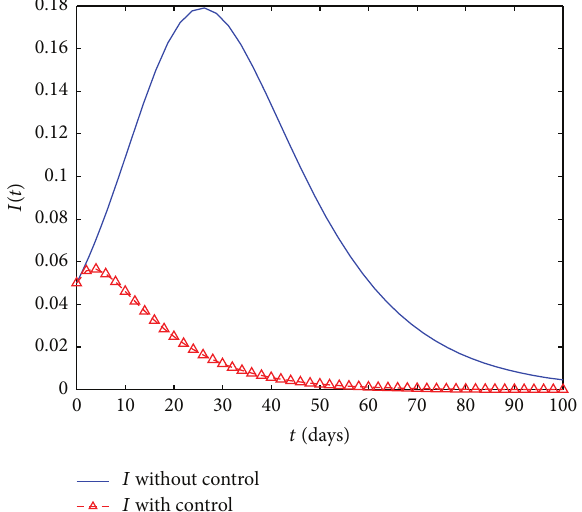
Figure 8: The function 𝐼(𝑡) of infected individuals with and without